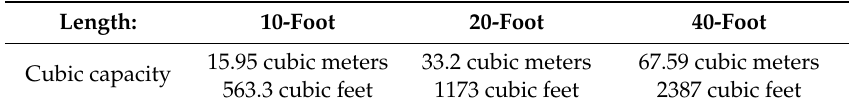
Table A2. Typical cubic capacities of standard shipping containers.